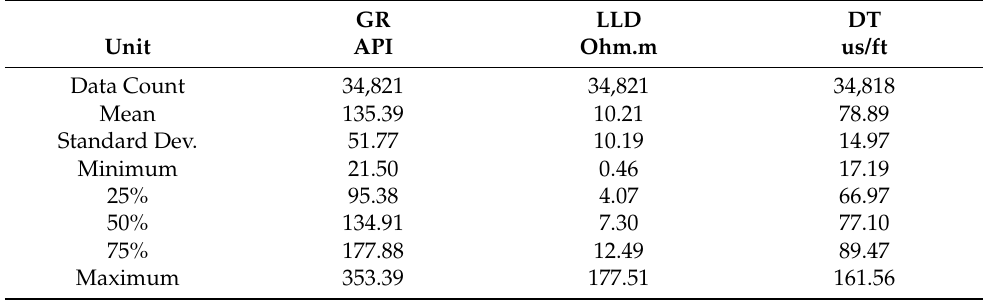
Figure 4. ( a ) Graphical illustration of bias and variance. The aim is to obtain a model that has low bias and low variance. ( b ) Contribution of bias and variance to the total error of the machine learning model (reproduced from the reference [57]). With increasing model complexity, error function reduced significantly for training data set but perform poorly in validation dataset, i.e., higher variance. The task to define a model in such a way that the bias and variance can tackle in validation and blind test data set. Table 2. Statistical description of input well log curves for synthetic NPHI and RHOB generation.